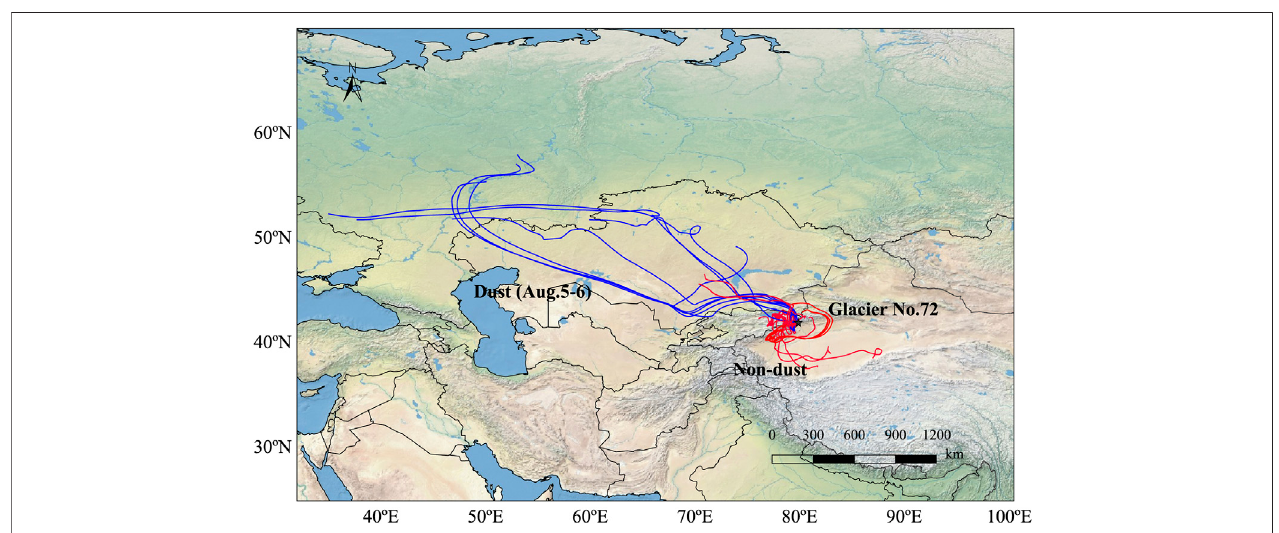
FIGURE7| Analysisofthe5-day airmassbacktrajectorieswithbeginningheightsat500 mabovegroundlevelatGlacierNo.72duringthesamplingperiods(July 2008 to August 2008).